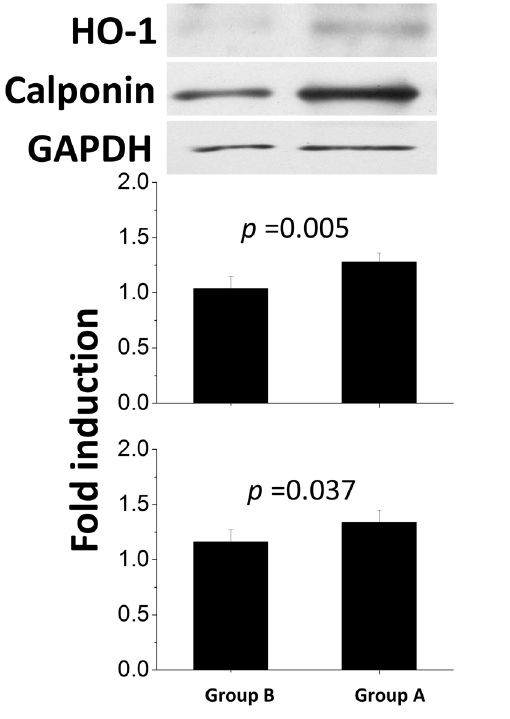
Figure 13. Quantitative analysis of Hol 1 and calponin content of arteries in groups A and B at week 24.